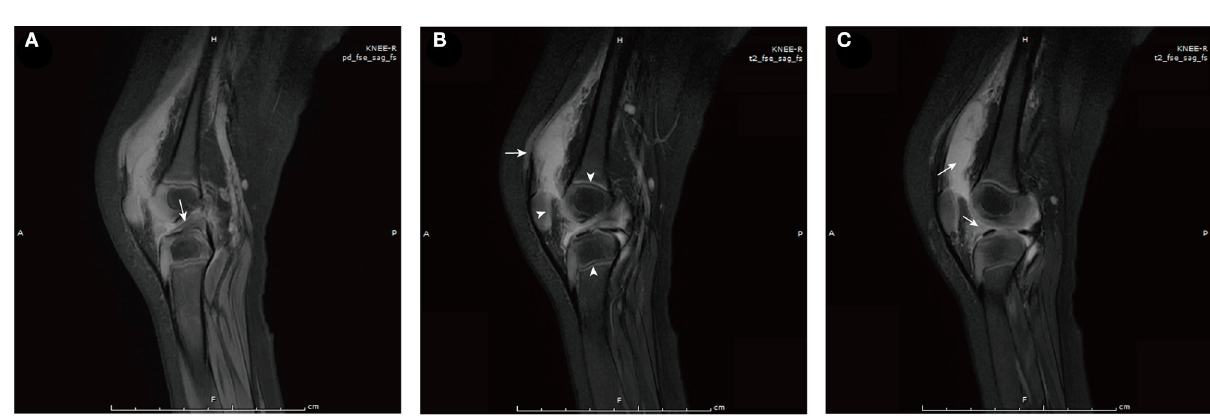
treatment. Soon after, arthroscopy-assisted synovial debridement and joint cavity drainage of the right knee were performed.